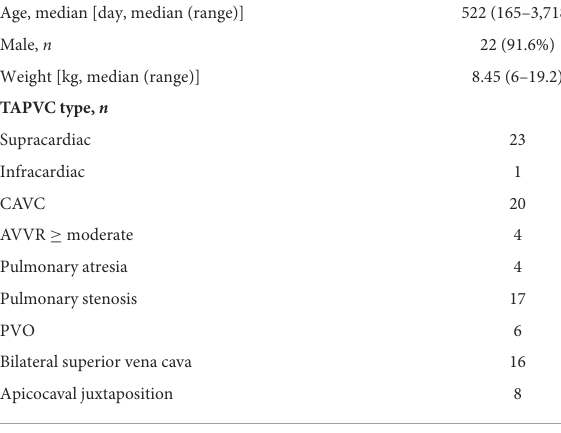
TABLE 1 Characteristics of patients with right atrial isomerism and TAPVC.